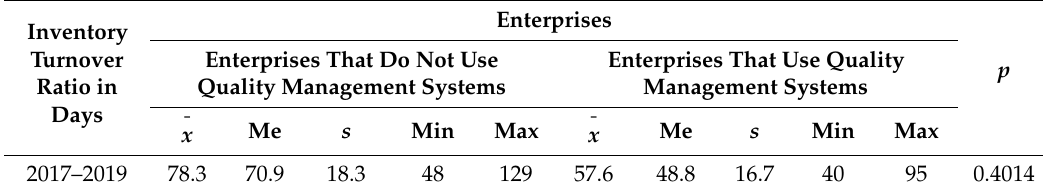
Table 7. Average results for the inventory turnover ratio in